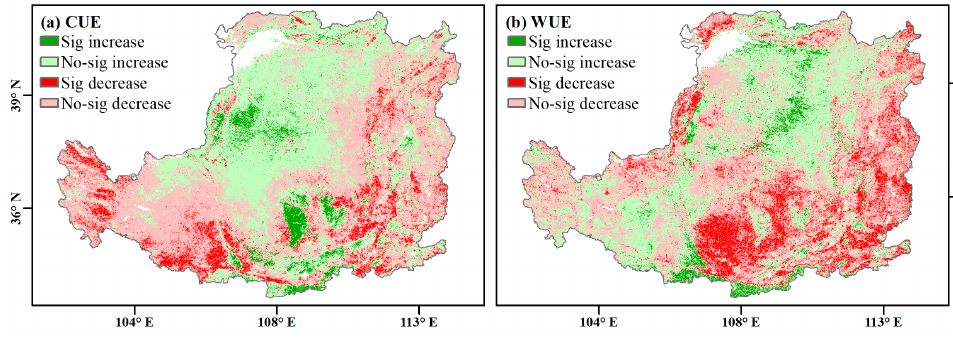
Figure 8. Correlation coefficients of CUE (a) and WUE (b) with temperature and precipitation for various Loess Plateau vegetation types ( ∗ : p < 0.05; ∗∗ : p < 0.01).